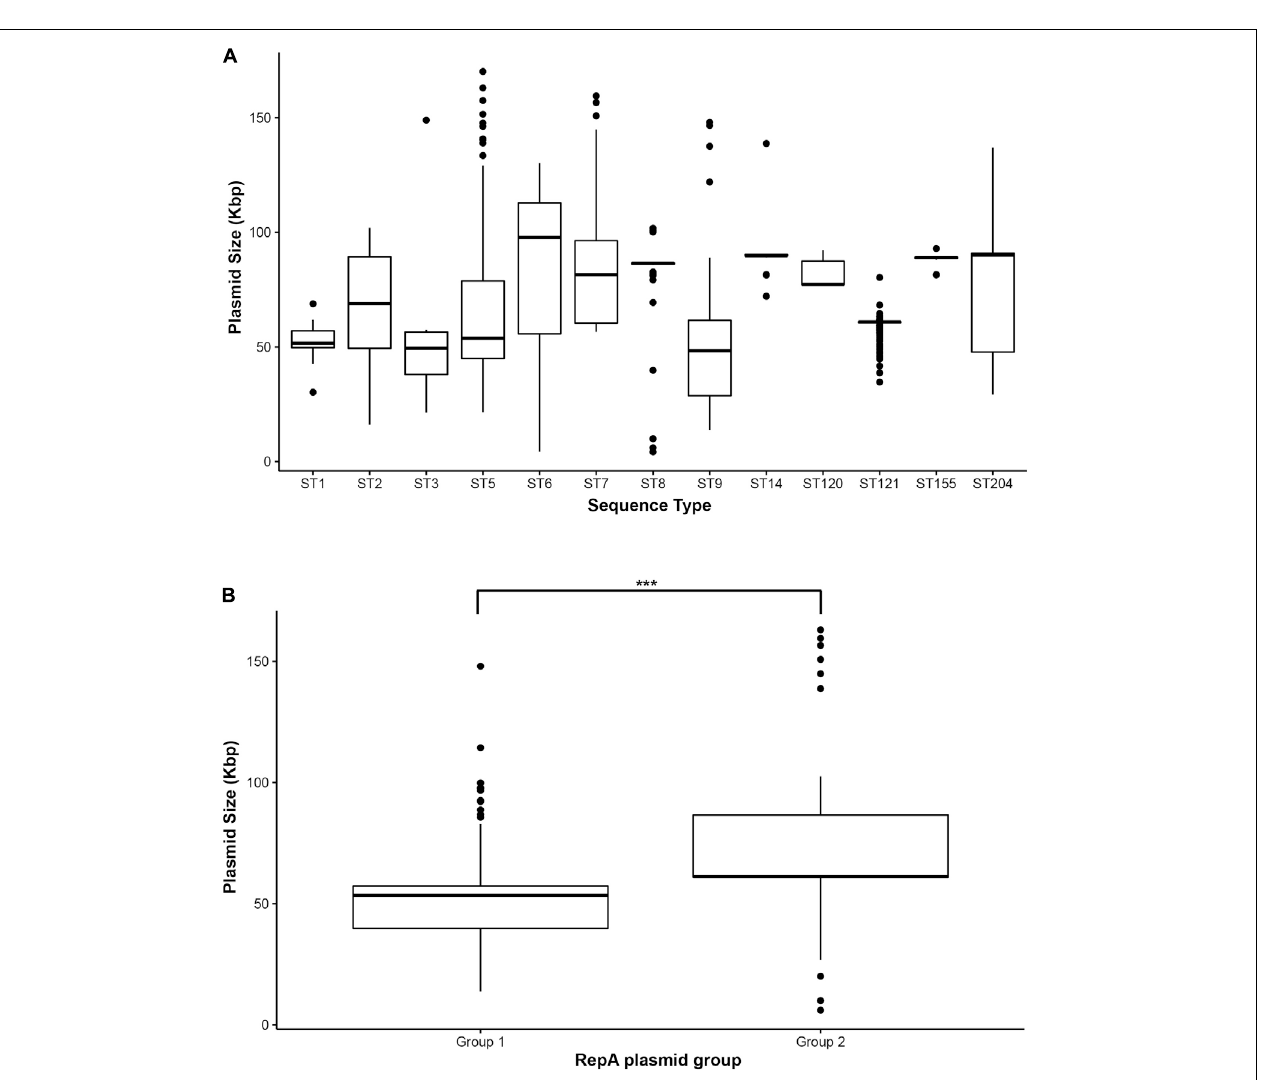
FIGURE 4 | Size distribution of Listeria monocytogenes plasmids visualized as Box-Whisker plots. (A) Size distribution of plasmids per ST, (B) size distribution of group 1 and group 2 RepA plasmids. ***Indicates p -value < 0.001 (paired two-tailed Student’s T -test).